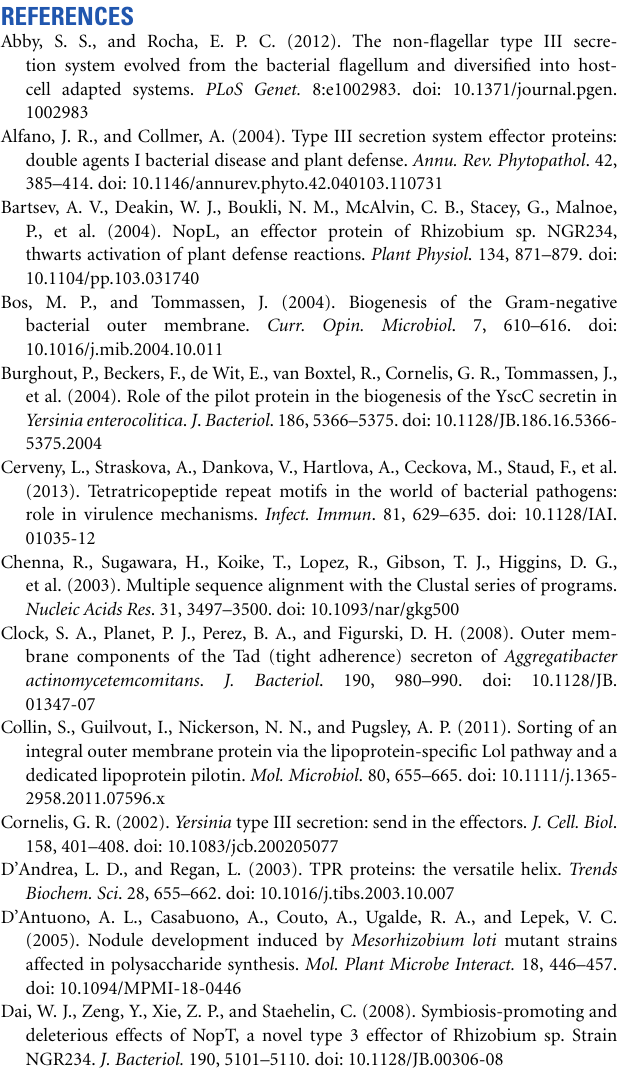
Supplementary Figure 2 | Alignment between the aminoacid sequences of TPR proteins using MUSCLE v(3.8.31) (Edgar,